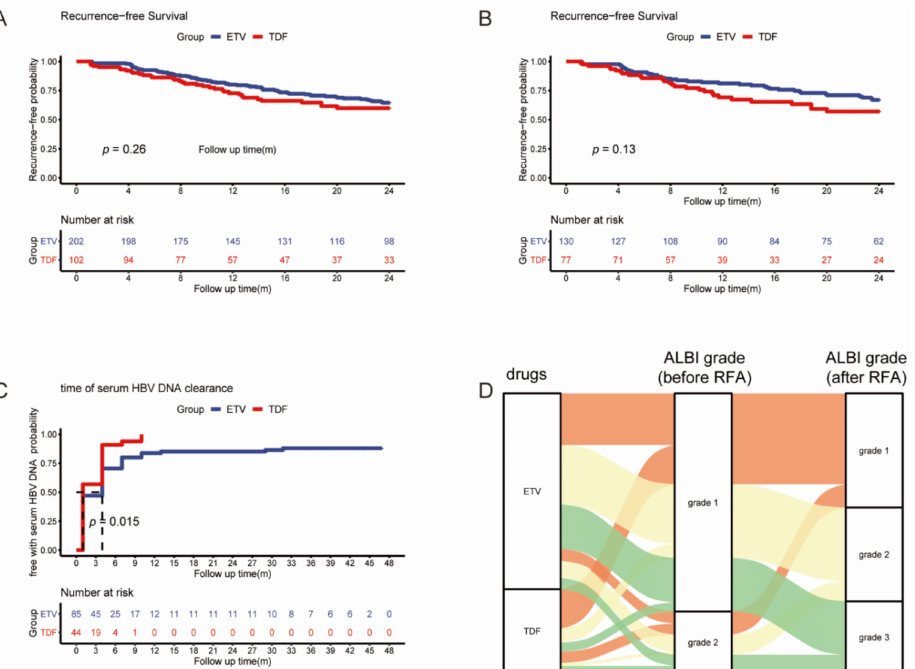
Figure 3. Kaplan–Meier curves of early recurrence between the two groups in full ( A ) and matched ( B ) cohorts; Kaplan–Meier curves of serum HBV DNA clearance between the two groups ( C ); Sankey diagram of ALBI grade change after RFA ( D